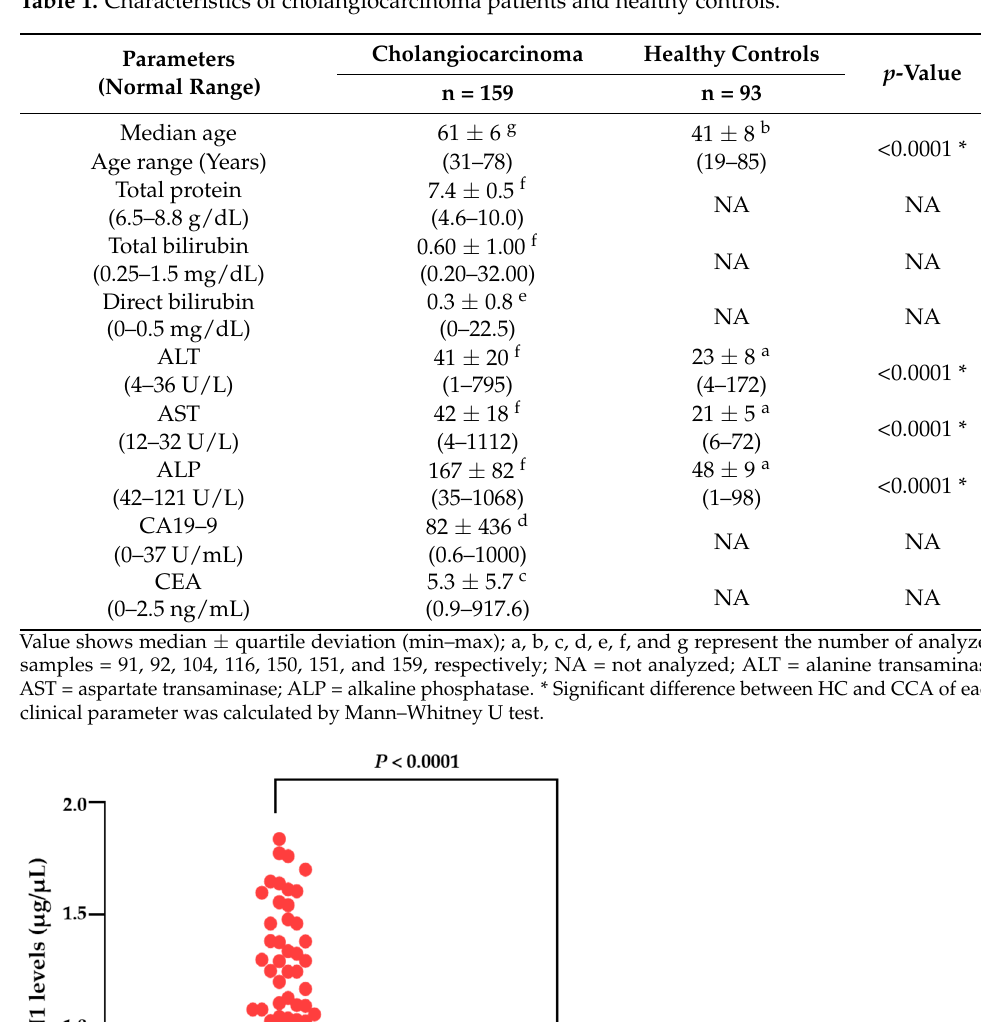
Table 1. Characteristics of cholangiocarcinoma patients and healthy controls.